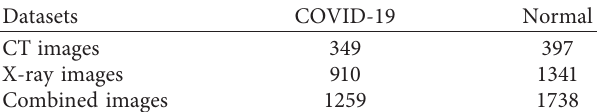
Table 3: X-ray and CT